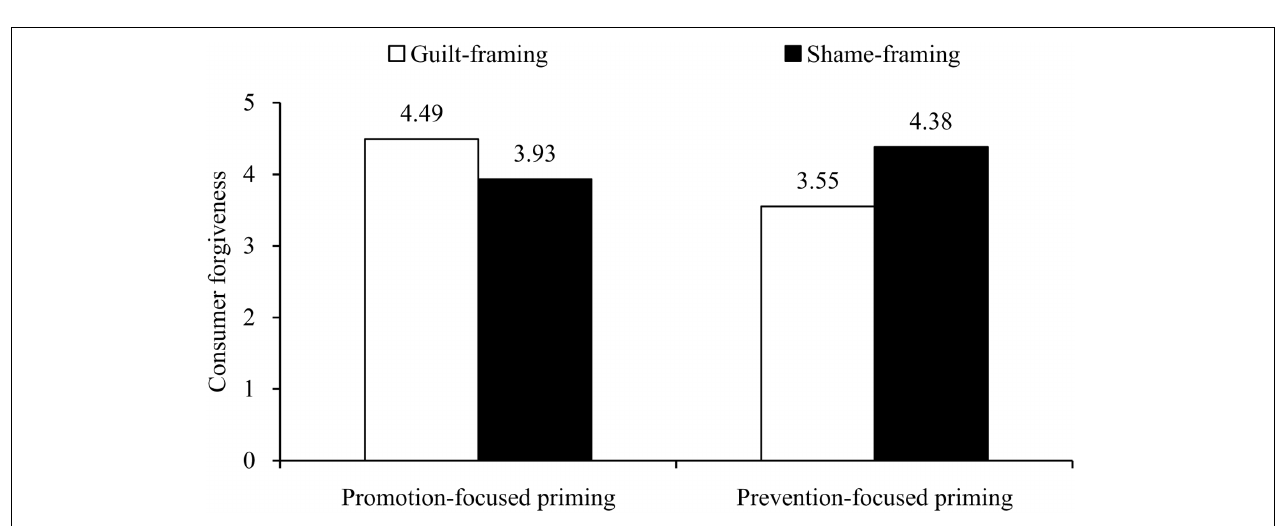
FIGURE 5 | Interaction effect of emotion and regulatory focus on forgiveness in the anger condition (Study 3).